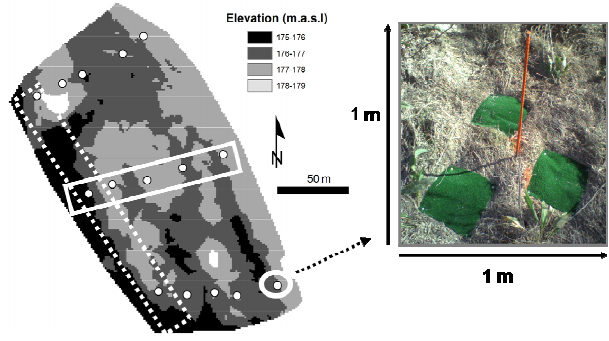
FIGURE 3 Fig. 3. Representation of the different spatial scales considered in one of the examined areas (MP, see Fig. 1). The biggest one, the study site scale, encounters the area containing all study plots within a site. The solid rectangle is an example of the area encountered by transects spatial scale, which represents the gradient perpendicular experimental settings where measurements are made on groups of related experimental units. If the 199 to the main channel. The dashed rectangle is an example of the area encountered by the row spatial scale, which represents the gradi- ent parallel to the main channel. The displayed picture shows the composition of one study plot (solid circle).